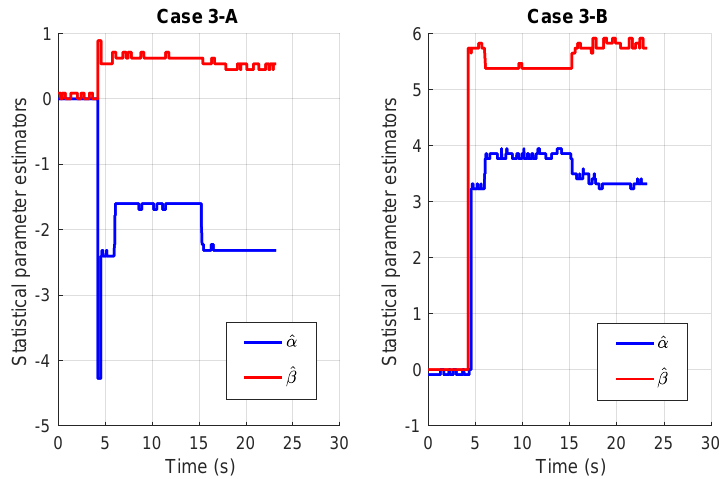
Figure 14. Case 3: Time evolution of the likelihood estimation of the parameters ˆ α and ˆ β . As for the previous scenarios, the parameters confirmed the detection of soil resistivity changes.